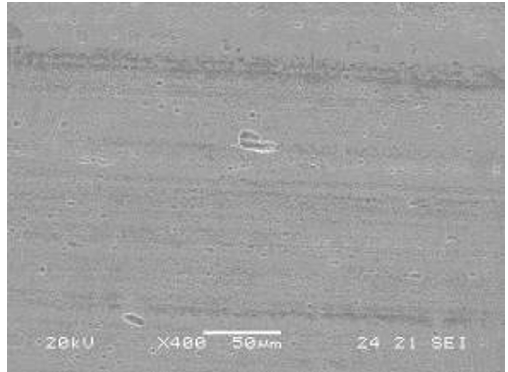
Fig. 15 Scanning electron microscope image of micro-pitted tooth.